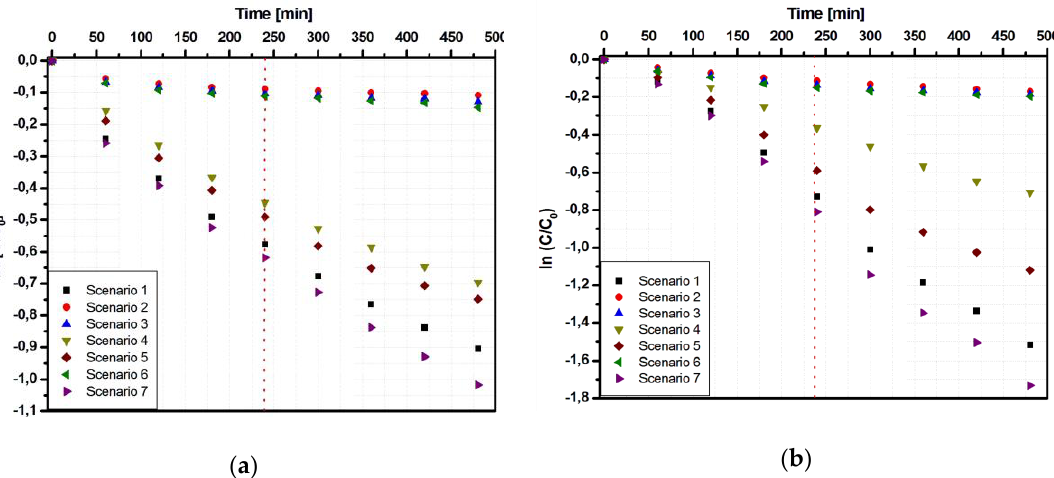
Figure 8. Kinetic data of the Ti_Al sample using the Langmuir–Hinshelwood correlation: ( a ) Tr and ( b ) Apd photodegradation.